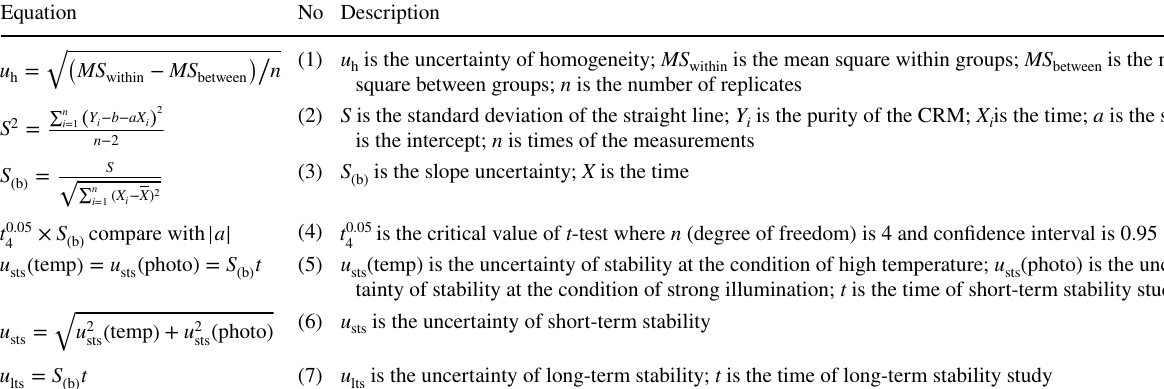
Table 1 Equations used in the homogeneity and stability studies of Sal A CRM Equation No Description